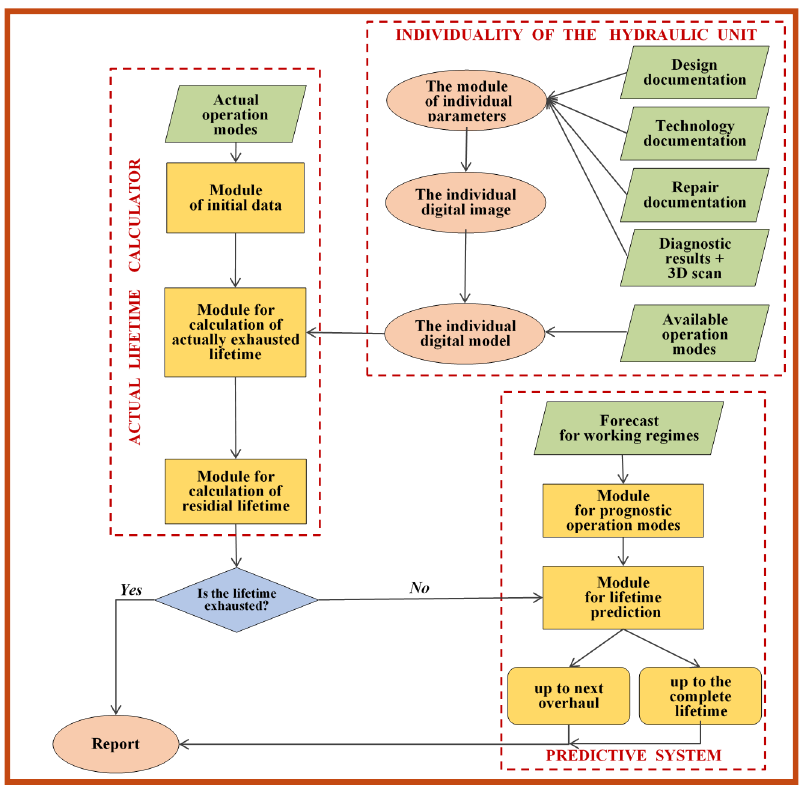
Figure 5. Conceptual diagram of the proposed analytical predictive system.